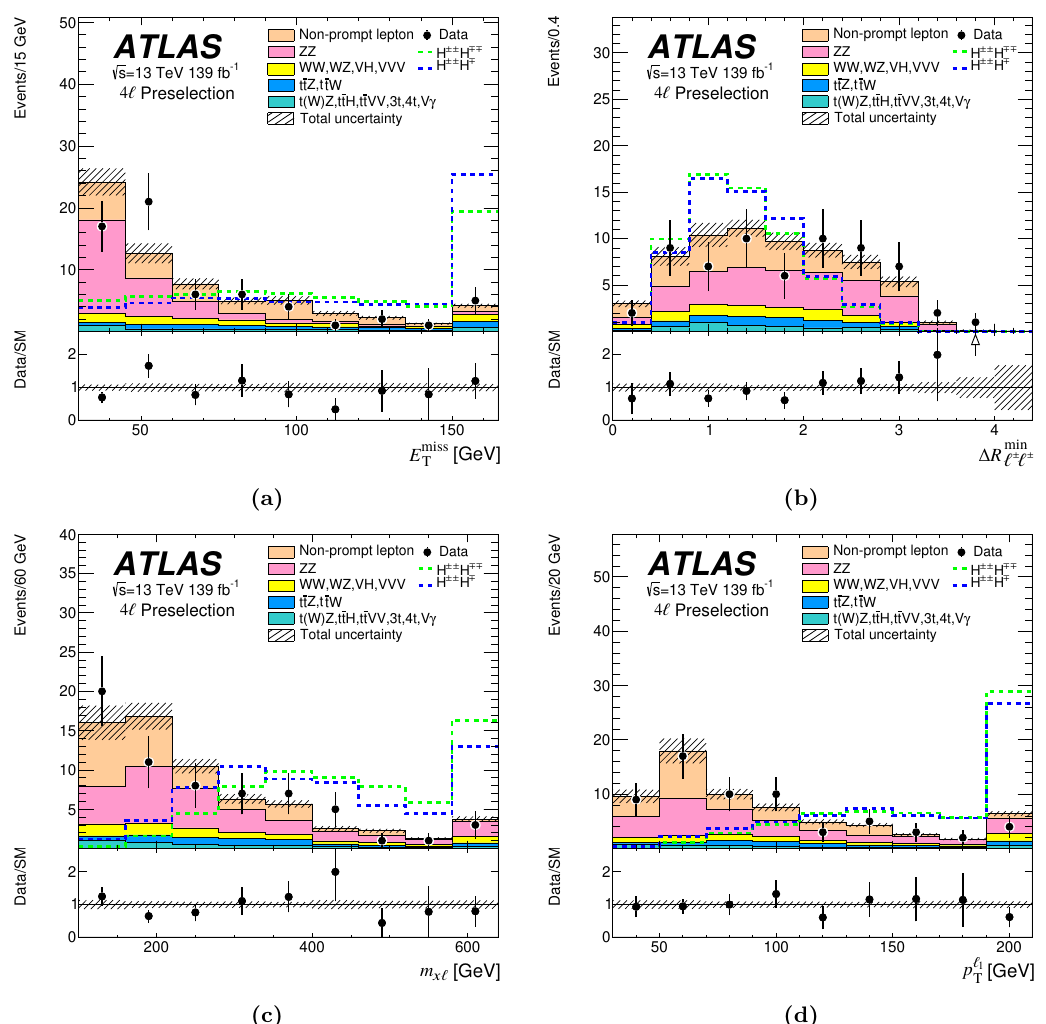
Figure 5 . Distribution of selected variables used to define the 4 ‘ SRs. The events are selected with the preselection requirements listed in table 4. The data (dots) are compared with the expected contributions from the relevant background sources (histograms). The expected signal distributions for m = 300 GeV are also shown, scaled to the observed number of events. The last bin includes H ±± overflows. In each figure the bottom panel shows the ratio of data to the estimated background. The hatched band around unity represents the total uncertainty of the